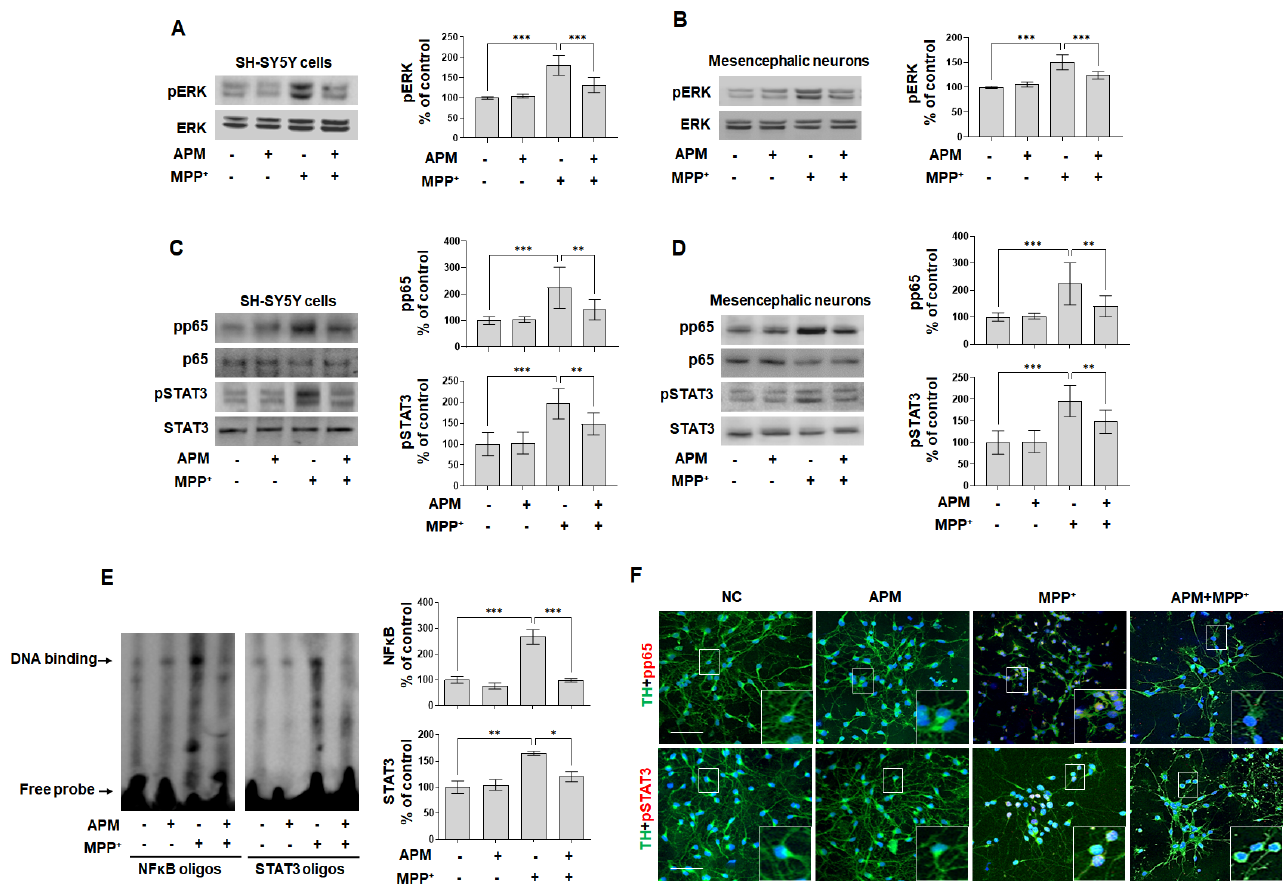
Figure 5. APM strongly inhibited MPP + -induced phosphorylation of MAPK-ERK/p65/STAT3 signaling pathway. Dopaminergic neuronal cells were incubated in the presence or absence of APM for 1 h and then treated with MPP + for 12 h. Phosphorylation of ERK in SH-SY5Y cells ( A ) and rat embryo primary mesencephalic neurons ( B ) were analyzed by immunoblotting. MPP + -induced NF κ B-p65 and STAT3 translocation in SH-SY5Y cells ( C ) and rat embryo primary mesencephalic neurons ( D ) were analyzed by immunoblotting. β Actin was used to confirm equal sample loading. ( E ) The DNA-binding activity of NF κ B-p65 and STAT3 in nuclear extracts was measured using EMSA. ( F ) Immunofluorescence double staining for TH (green) and pp65 (red) localization, and TH (green) and pSTAT3 (red) localization, in rat embryo primary mesencephalic neurons. Scale bars: 50 µ m. Nuclei were stained with DAPI (blue). Immunoblotting and EMSA were quantified by densitometric analysis. The data are representative of three independent experiments and quantified as mean values ± SEM. Tukey’s multiple comparison test, * p < 0.05, ** p < 0.01, *** p < 0.001 compared to normal